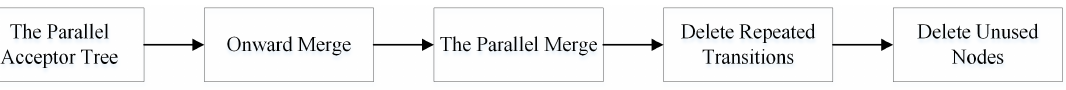
Figure 1. The parallel activity log inference algorithm (PALIA) suite